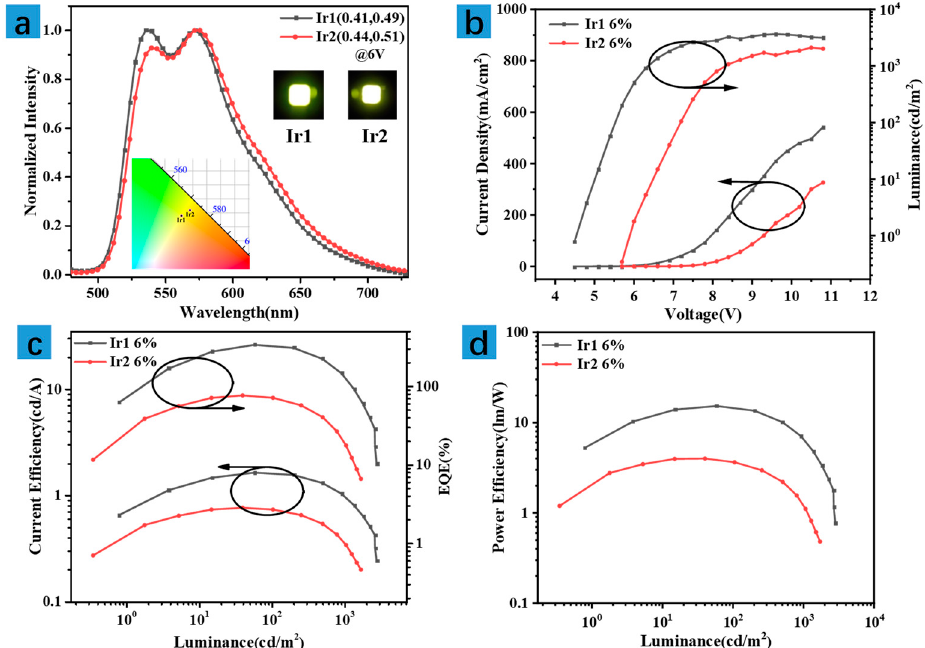
Figure 4. ( a ) The normalized EL spectra, ( b ) the J-V-L curves, ( c ) CE-L-EQE curves, and ( d ) PE-L curves of the yellow OLEDs based on Ir1 and Ir2 with the doping concentration of 6% in CBP. Inset: EL photographs of OLEDs under the voltage of 6 V.